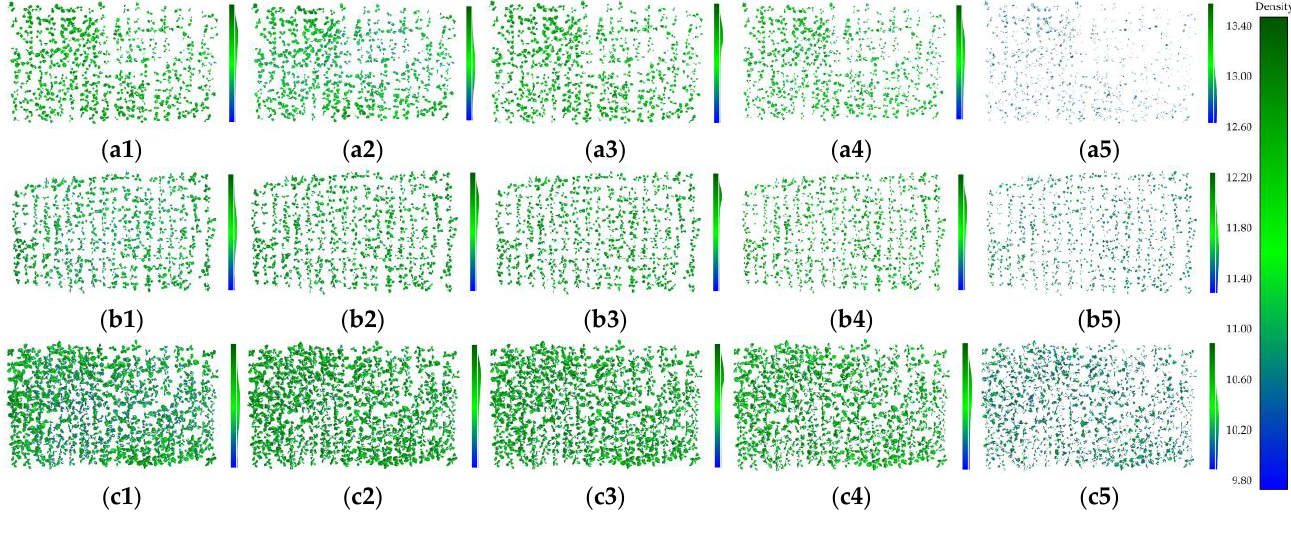
Figure 11. 3D surface model output in LA-DT of field rapeseed point cloud at different densities. To the right of the legend in the subfigure is a histogram of the mesh surface point cloud density. ( a – c ) The LA-DT outputs of Rapeseed-01, Rapeseed-02 and Rapeseed-03, respectively; ( 1 ) The LA-DT output of the initial rapeseed point cloud without point cloud thinning, ( 2 ) – ( 5 ) The LA-DT output of rapeseed point clouds filtered with voxels of 2 mm, 3 mm, 5 mm and 7 mm edge lengths, respectively.